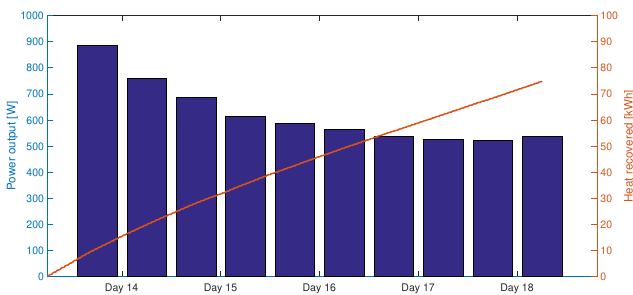
Figure 19. Bar plot—power output and heat recovery over the 5-day